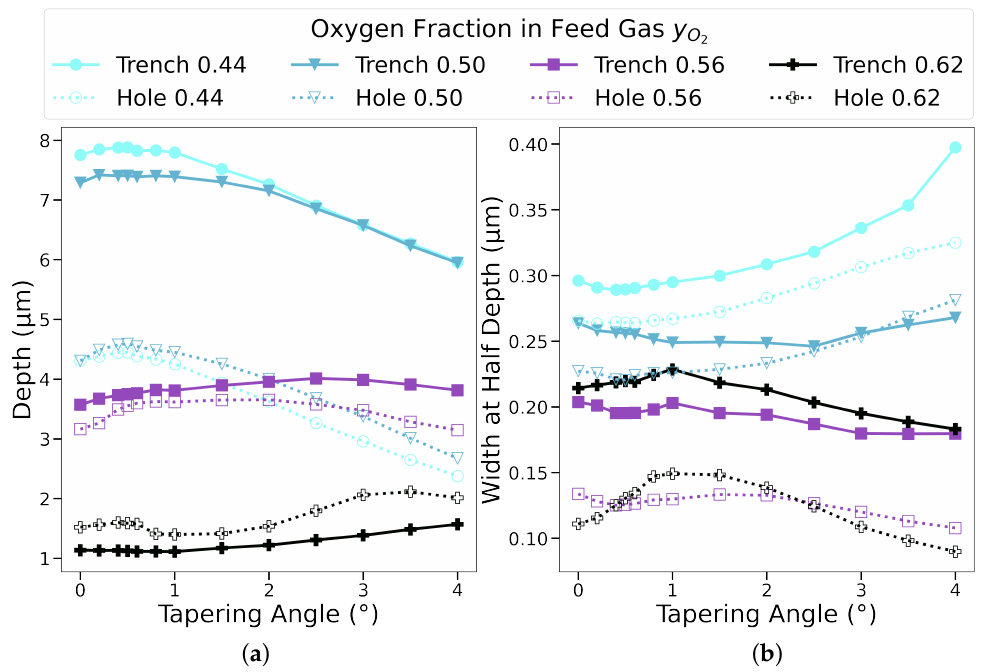
Figure 11. ( a ) Depth and ( b ) width at half-depth (WAHD) for trenches denoted with a solid line with squares, and holes shown with a dashed line with circles. Trench geometries exhibit higher vertical and lateral